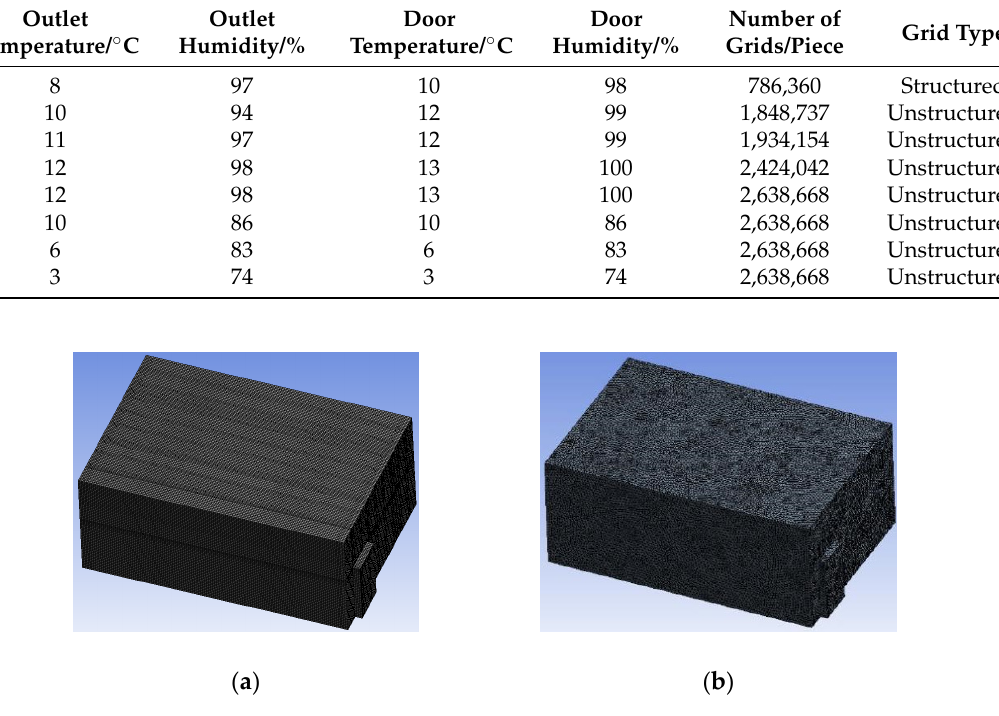
Figure 2. Grid division structure diagram of chiller after cooling for 0 h ( a ) and 8 h ( b ).